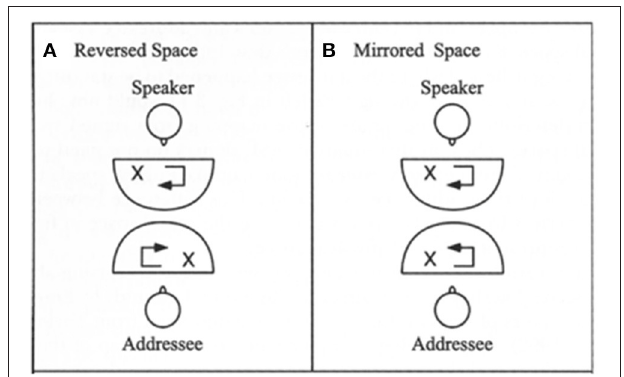
FIGURE 2 | A signed spatial mapping correctly reversed (A) and incorrectly mirrored (B) (reproduced from Emmorey (2002: 415)). Used by permission. All rights